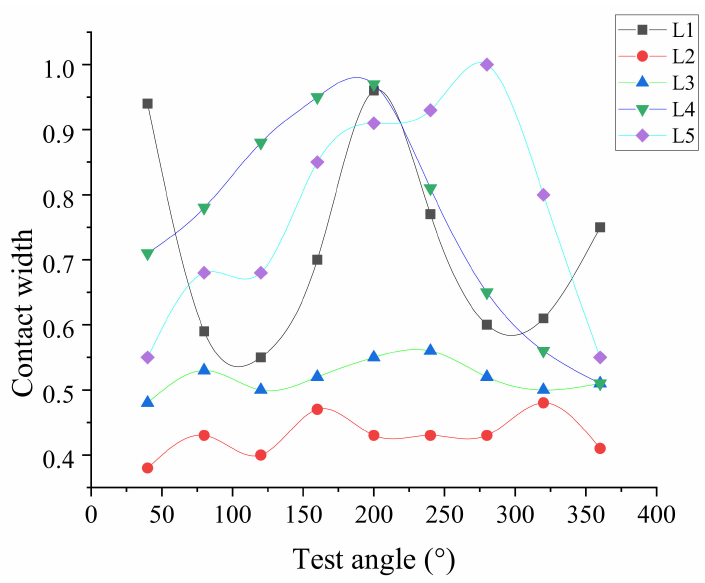
Figure 7. The contact width of each angle of the cylinder. Results indicate that the synergy effects of roundness and straightness have a signifi- cant influence on the contact width of the actual seal.